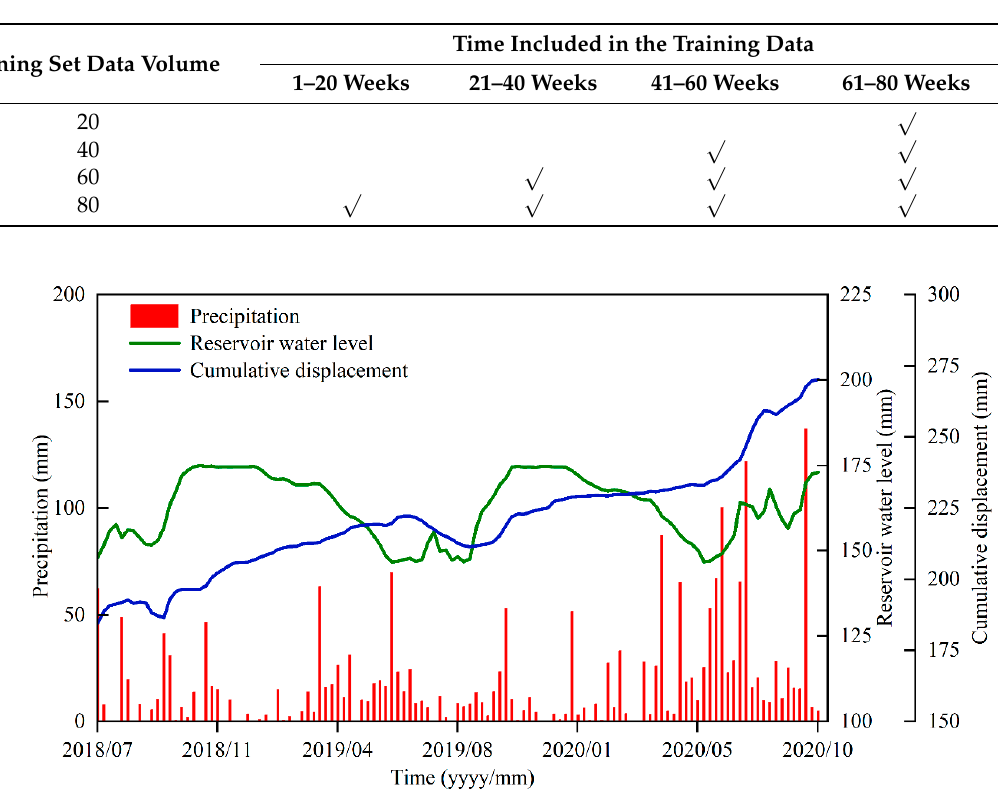
Table 1. The training set of the prediction model.